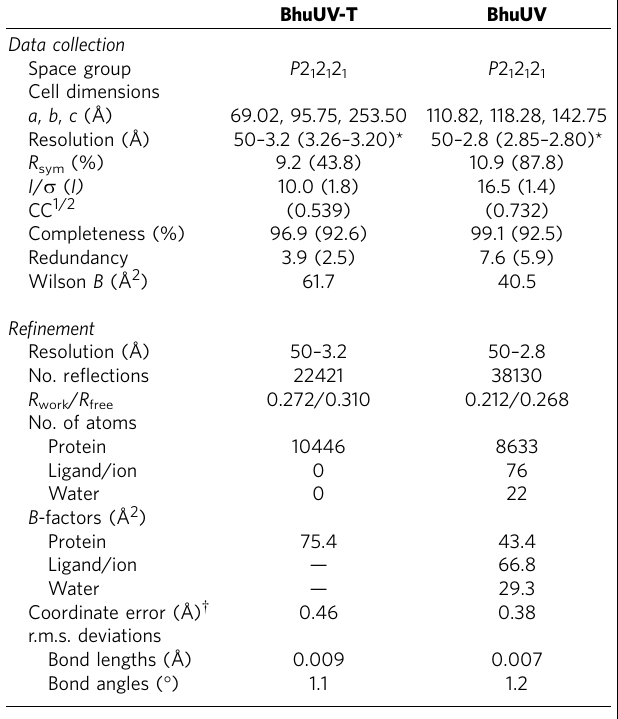
Table 1 | Data collection and refinement